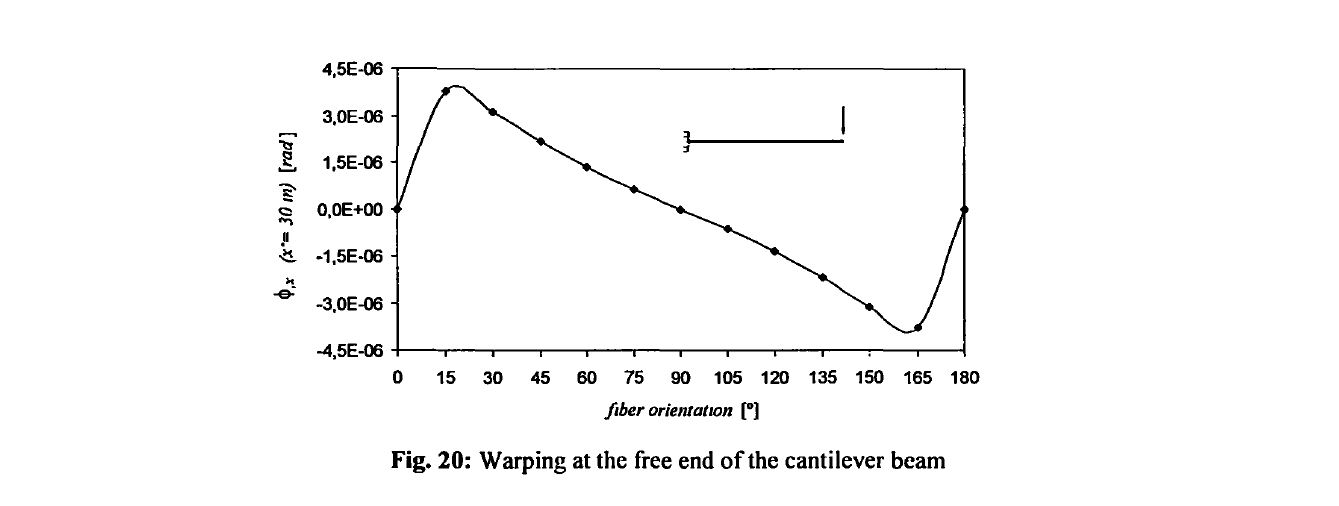
Fig. 20: Warping at the free end of the cantilever beam